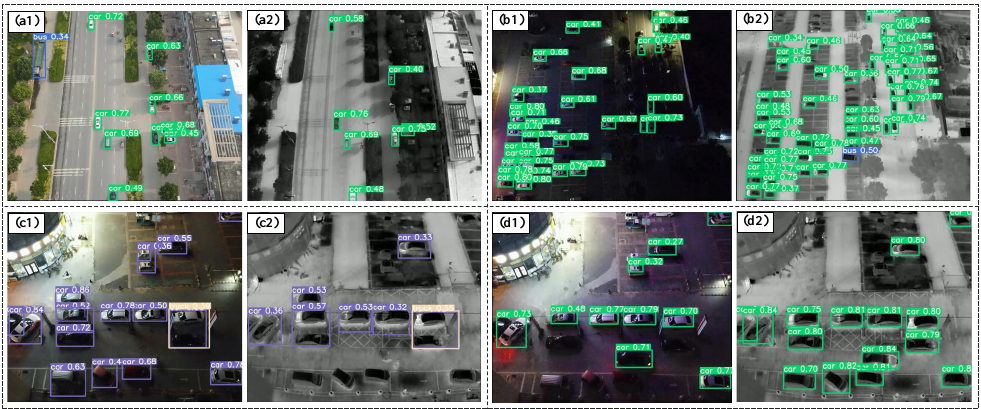
Figure 3. The effect of separate detection of infrared images and visible images. a(1) , a(2) , c(1) , and c(2) are training and detection results for single visible data. b(1) , b(2) , d(1) , and d(2) are training and detection results for single infrared data. This is a collection of images taken from a drone. The images are taken during the day and night. The drone flies at altitudes of 100 m and 200